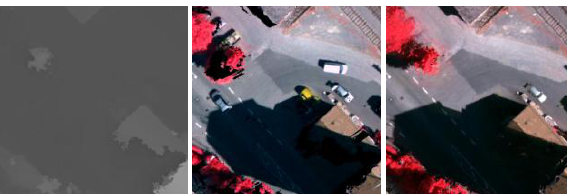
Figure 1: Detail of a test site. Left: DSM; centre: raw true orthophoto with void areas in black; right: combined true